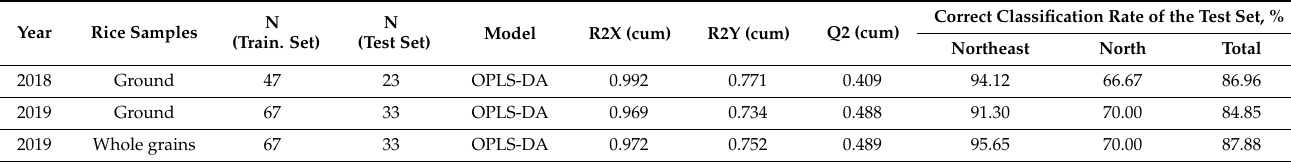
Table 4. Handheld NIR: goodness of fit and predictive ability of OPLS-DA models for the 2018 and 2019